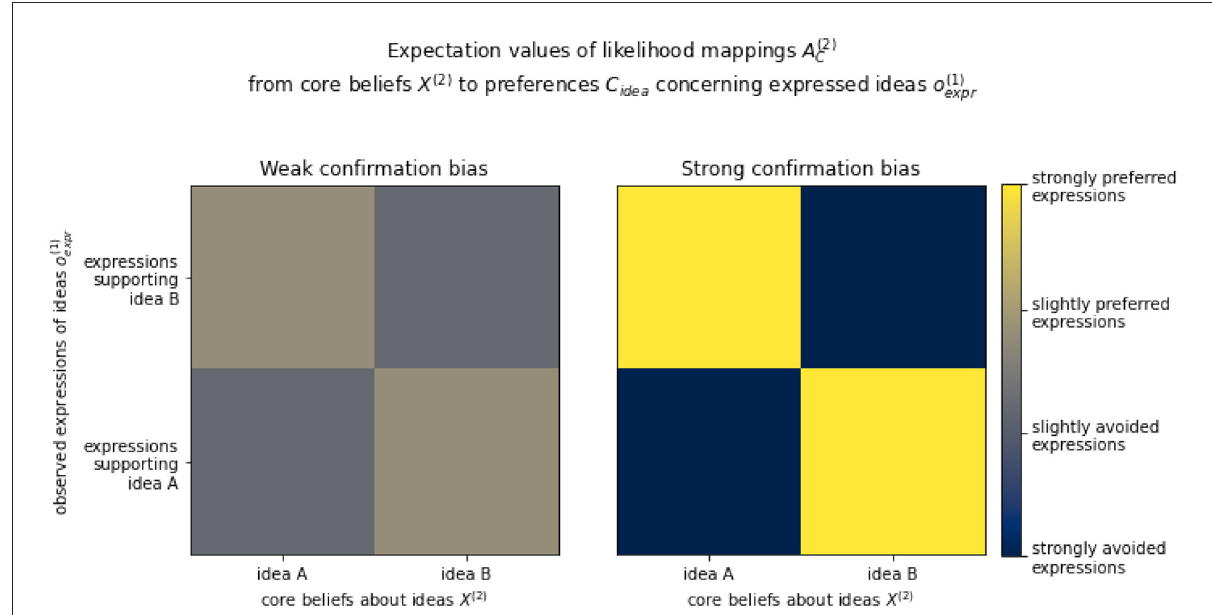
FIGURE5 Two sets of expectation values of the Dirichlet distributions used to generate top-down likelihood mappings A (2) C , from core beliefs about ideas X (2) to preferences concerning expressed ideas C idea , representing the two distinct populations for which parameters were initialized with different degrees of confirmation bias. Weak confirmation bias (Left) corresponded to mild preferences for observed expressions to confirm core beliefs, while strong confirmation bias (Right) corresponded to a strong preference for observed expressions to confirm core beliefs (essentially a one-to-one